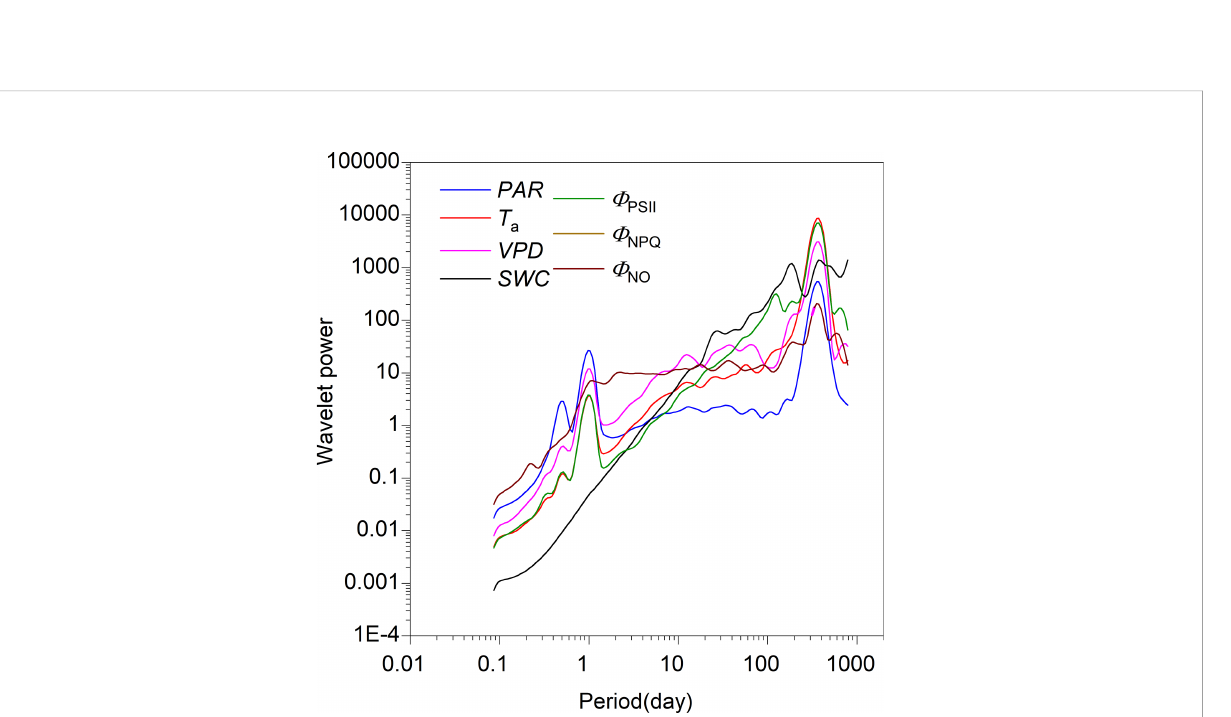
FIGURE 4 Global wavelet power spectra for photosynthetically active radiation ( PAR ), air temperature ( T a ), vapor pressure de fi cit ( VPD ), soil water content at a 0.3-m depth ( SWC ), photochemical ef fi ciency ( F PSII ), and regulatory and non-regulatory thermal dissipation ( F NPQ and F NO , respectively).